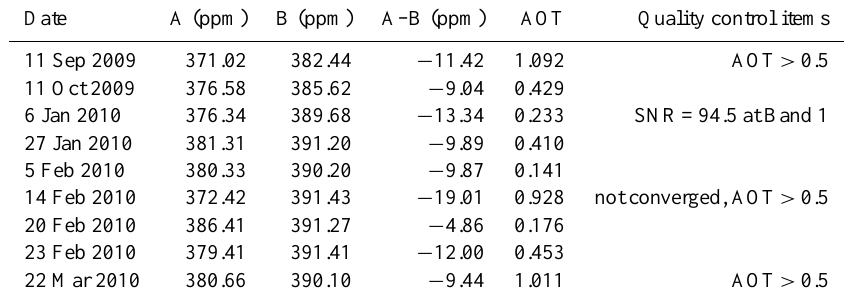
Table 2. Comparison of GOSAT SWIR XCO 2 (A) with Tsukuba TCCON XCO 2 (B) and the quality control items not satisfactory for data